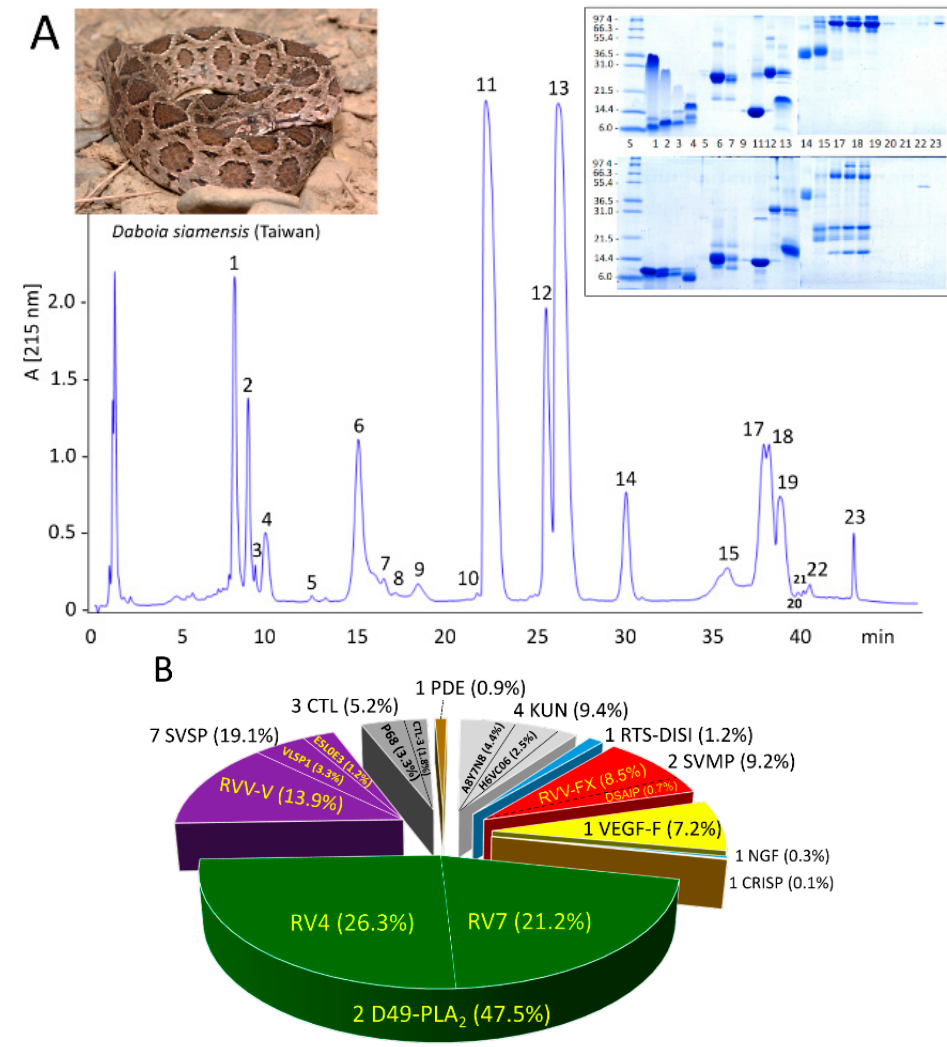
Figure 1. Venomics analysis of D. siamensis from Taiwan. Panel ( A ), reverse-phase chromatographic separation of the venom proteins. Chromatographic fractions were collected manually and analyzed by SDS-PAGE (inset) under non-reduced (upper panels) and reduced (lower panels) conditions. Protein bands were excised, in-gel digested with trypsin, and the resulting tryptic peptides sequenced by LC-nESI-MS/MS and identified by database searching or de novo sequencing (Supplementary Materials Table S1). Panel ( B ), pie chart displaying the number and relative occurrence (in percentage of total venom proteins) of toxins from different protein families identified in the venom proteome (listed in Table 1). Acronyms: D49-PLA 2 , D49 phospholipase A 2 ; SVSP, snake venom serine protease; CTL, C-type lectin-like; PDE, phosphodiesterase; KUN, Kunitz-type serine proteinase inhibitor-like protein; RTS-DISI, RTS-disintegrin; SVMP, snake venom metalloptoteinase; VEGF, vascular endothelial growth factor; NGF, nerve growth factor; CRISP, cysteine-rich secretory protein. The venom proteome of D. siamensis (Taiwan) comprises 25 distinct gene products (Table 1), including seven snake venom serine proteinases (SVSP), four Kunitz-type serine proteinase inhibitor-like (KUN) molecules; five C-type lectin-like (CTL) proteins; two snake venom metalloproteinases (SVMP); two phospholipase A 2 (PLA 2 ) molecules, and one protein species of each RTS-disintegrin (DISI), vascular endothelial growth factor (VEGF), nerve growth factor (NGF), cysteine-rich secretory protein (CRISP), and phosphodiesterase (PDE) protein families (Table 1).